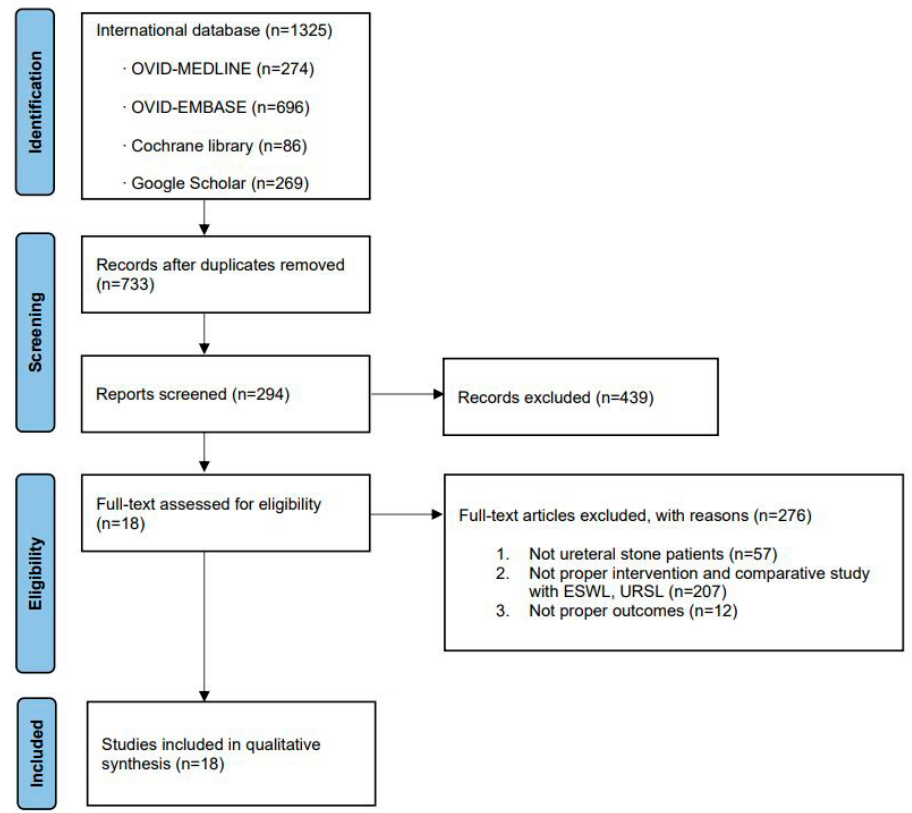
Figure 1. Study flow chart.